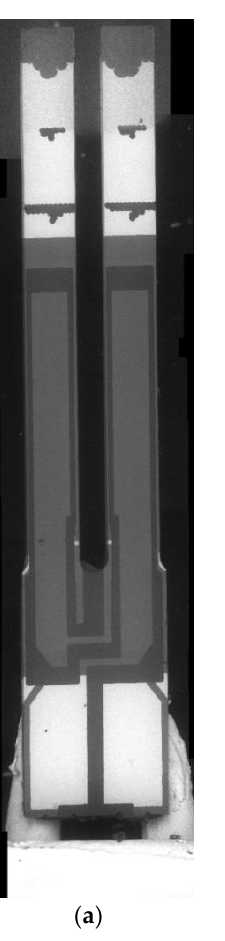
Figure 16. Determination of the length of the proof mass from a microscope image.